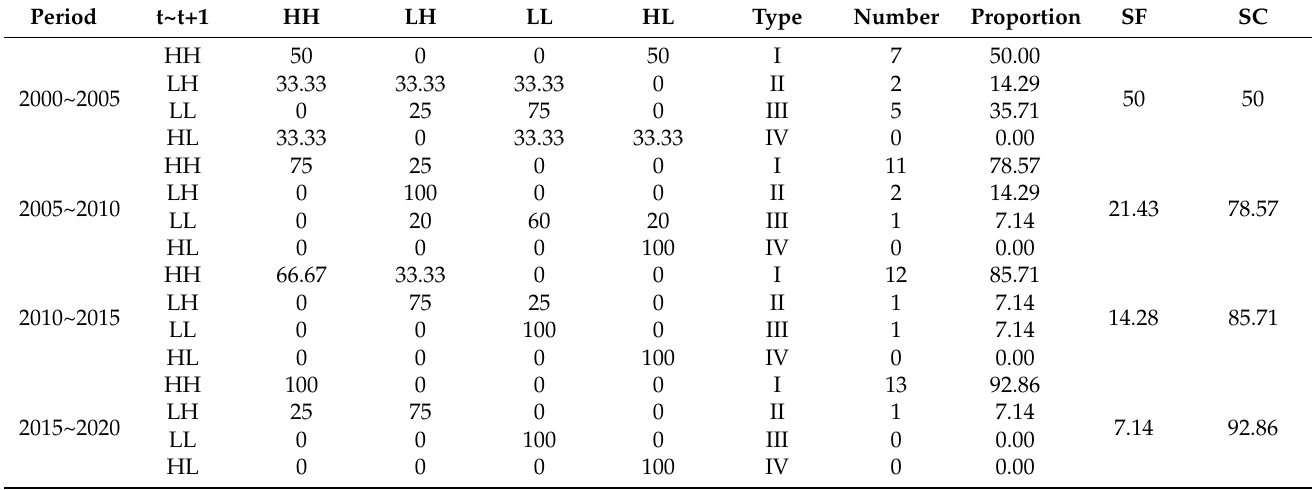
Table 4. Moran’s I Transition probability matrix and spatiotemporal transition of carbon